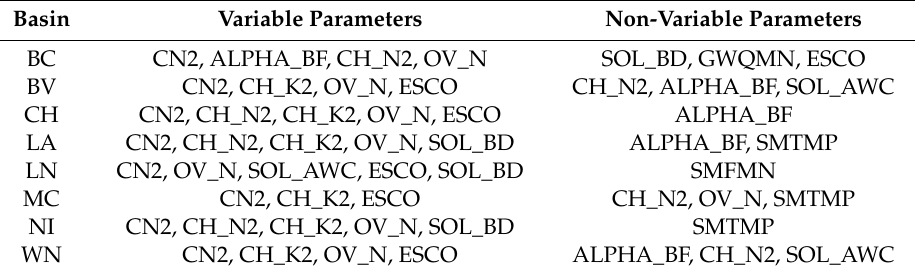
Table 5. Highly sensitive parameters (HSP) from IT_Q